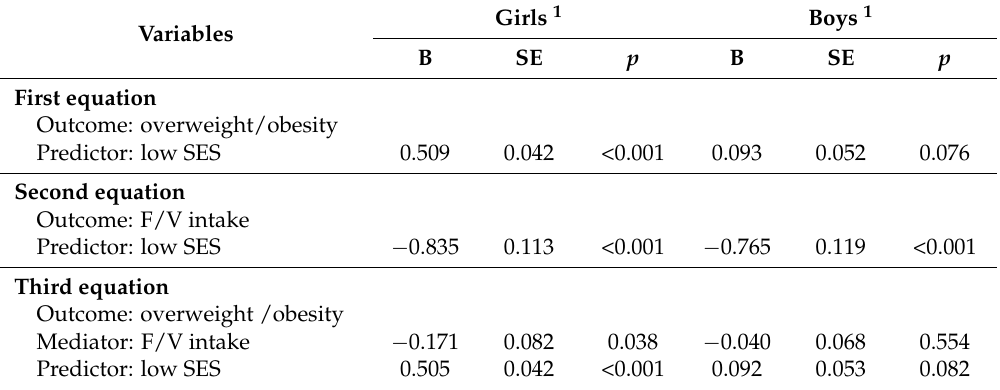
Table 3. Testing for a mediating effect of fruit/vegetable intakes on the association between SES